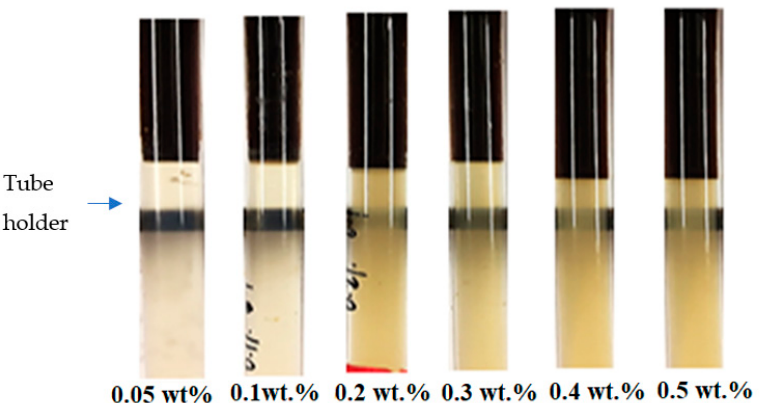
Figure 10. Phase behavior of the as-synthesized surfactant with 35 wt.% co-solvent mixture at dif- ferent concentrations in ratio D (6:1). different concentrations in ratio D